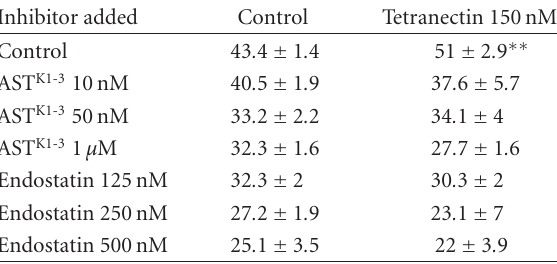
Table 2. E ff ect of tetranectin on endothelial cell proliferation in presence of control bu ff er, AST K1-3 or endostatin. Endothe- lial cell cultures were incubated for 72 hours in presence of the indicated concentrations of recombinant wild-type tetranectin, AST K1-3 , or endostatin alone or combinations of AST K1-3 or en- dostatin with tetranectin (final concentration 150nM). Results represent mean ± SD number of cells/mL ( × 1000) in 4–6 exper- iments (each done in triplicate). All concentrations of AST K1-3 or endostatin significantly decreased endothelial cells numbers ( P < . 05) in presence or absence of tetranectin. Tetranectin alone significantly ( P < . 01) increased the number of endothelial cells compared with control bu ff er alone although it did not alter the e ff ects of any concentration of AST K1-3 or